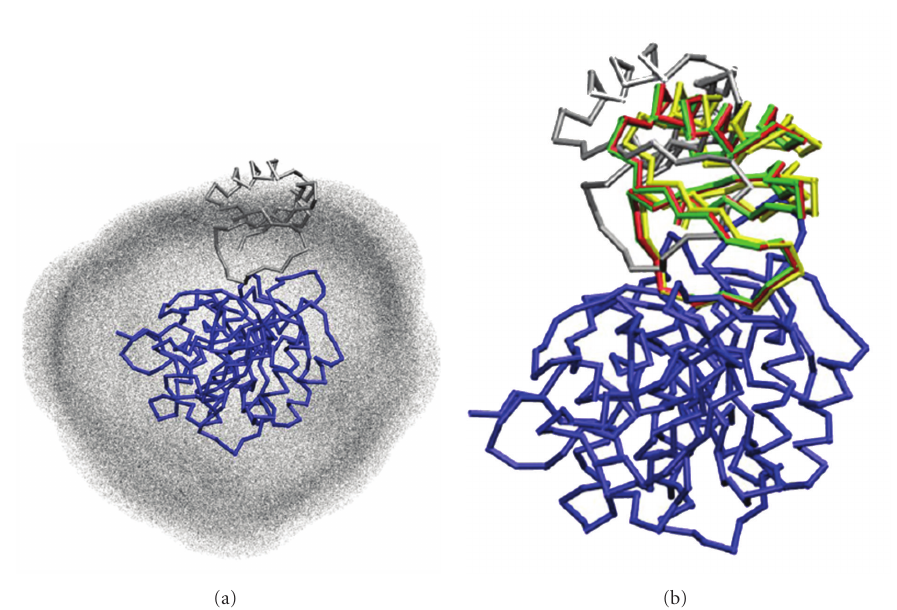
Figure 7: BD sampling and structure refinement of 2SNI. (a) 428,140 compact complexes obtained from BD global sampling. Each gray point represents the center of mass (COM) of one sampled conformation. The receptor of crystal complex is in blue, and near-native conformation obtained after BD sampling is in silver. (b) Representation of near-native conformations obtained from BD sampling (silver, RMSD 11.47 ˚A), soft potential optimization (yellow, RMSD 2.45 ˚A) and real potential optimization (red, RMSD 0.27 ˚A). The receptor and the ligand of crystal complex are in blue and green,